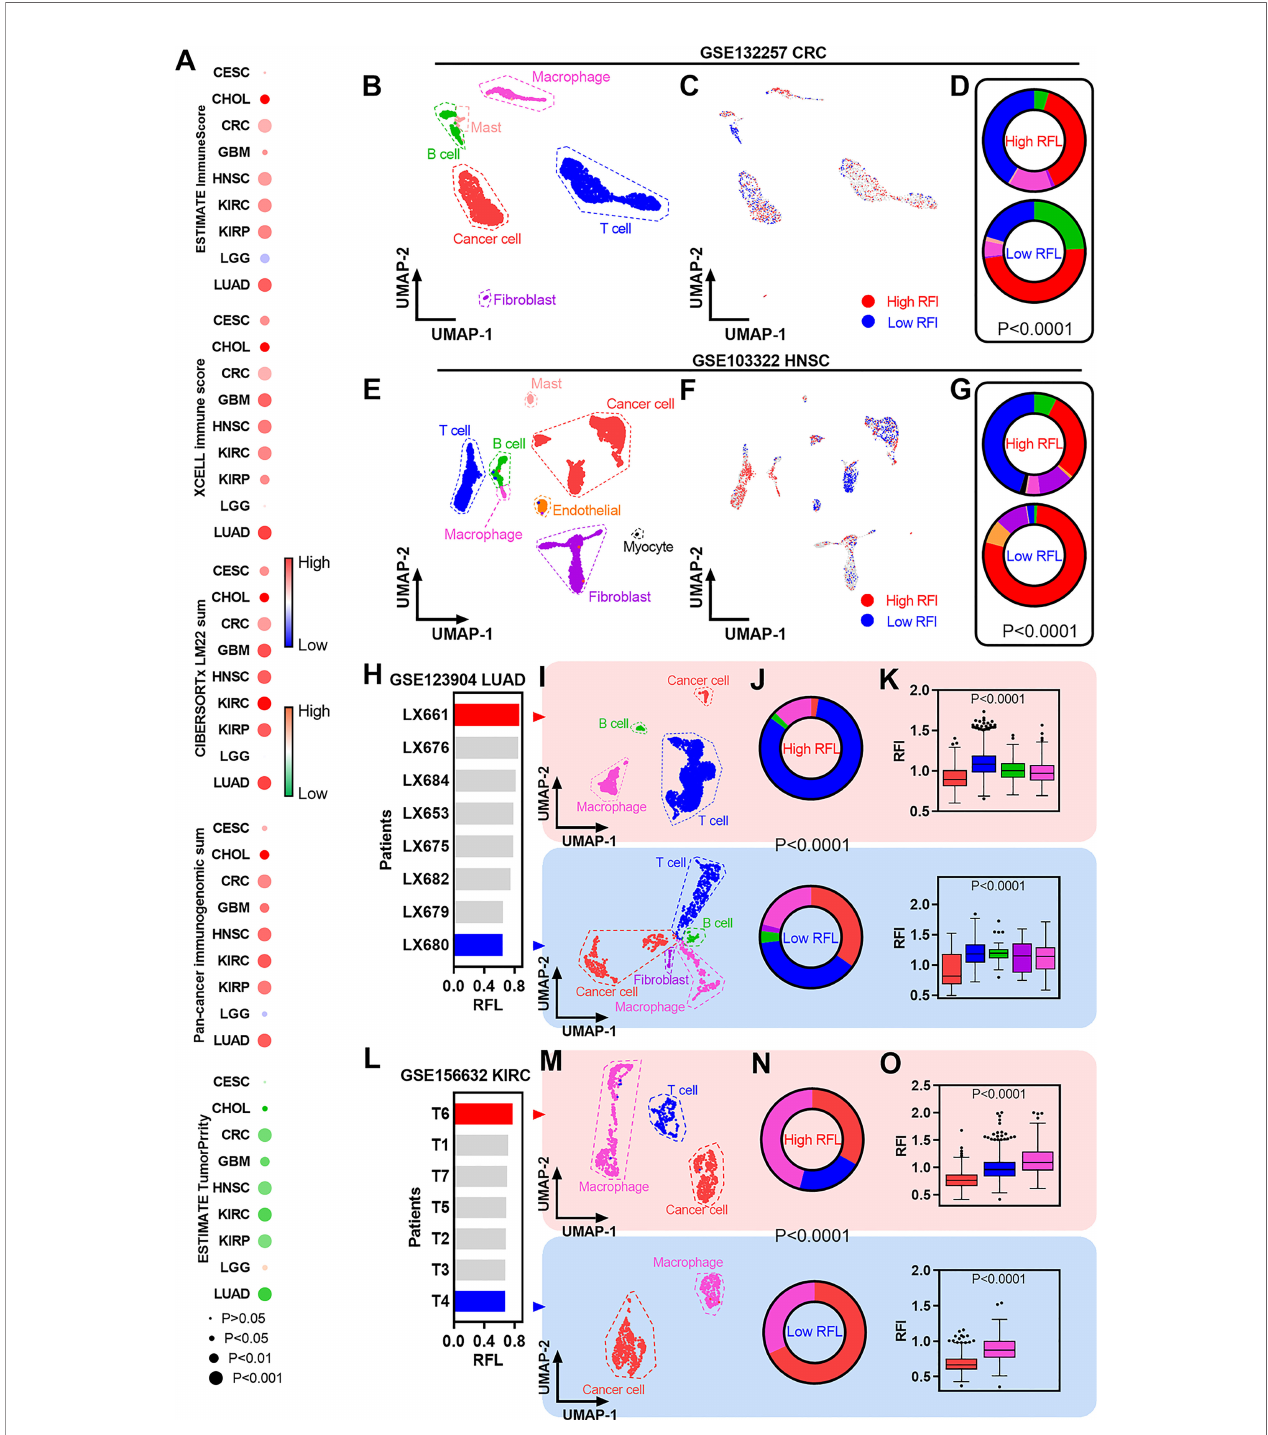
FIGURE 5 | Immune characterization of ferroptosis-associated signatures across cancer types. (A) Heatmaps showing the correlation levels between RFL and total immune in fi ltration/tumor purity. (B) UMAP plot showing cell type clusters in the GSE132257 dataset. (C) UMAP plot showing high and low RFL cell subpopulations in GSE132257 dataset. (D) Pie charts showing the distribution of cell types in high- and low-RFL cell subpopulations related to (B,C) . (E – G) Simila to (B – D) , but in GSE103322 dataset. (H) Barplots showing the RFL in patients from the GSE123904 dataset based on pseudo bulk transcriptome data. (I) UMAP plot showing cell type clusters in LX661 and LX661 patients from the GSE123904 dataset. (J) Pie charts showing the distribution of cell types in LX661 and LX661 patients. (K) Box plots show RFL levels grouped by cell types in LX661 and LX661 (L – O) Similar to (H – K) ,but in GSE156632